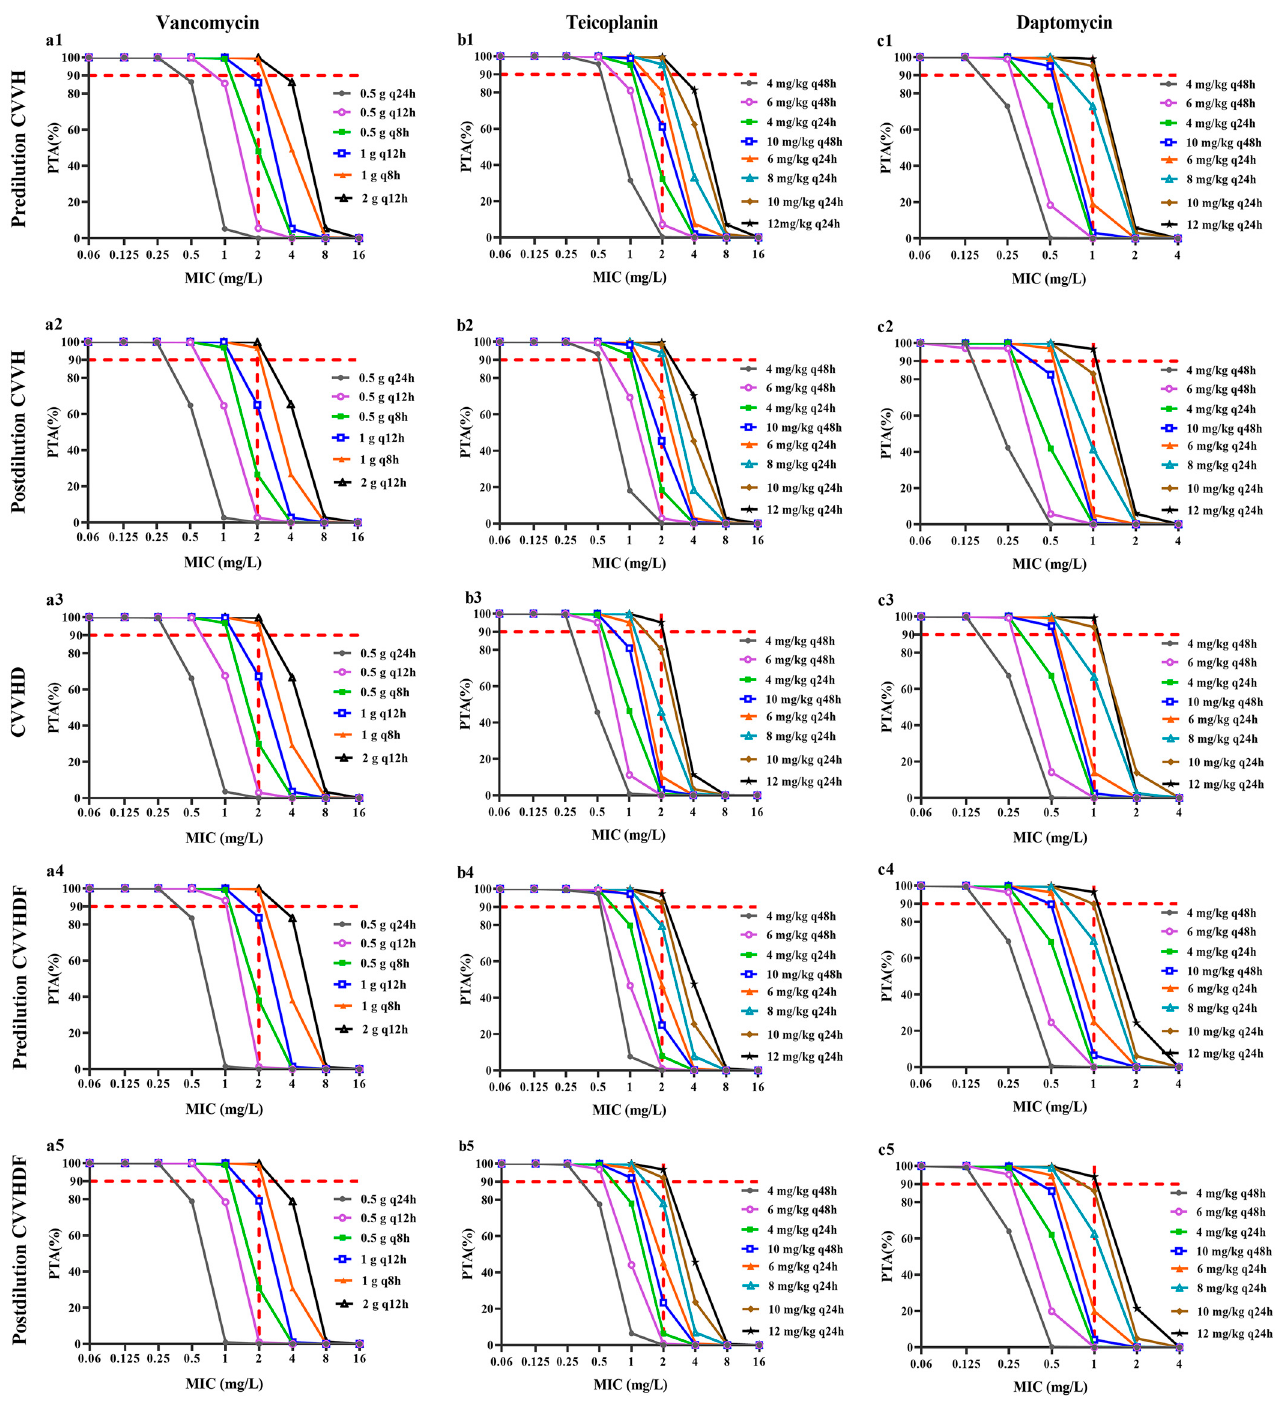
Figure 2. The probability of target attainment (PTA) values of three antimicrobial agents in different maintenance doses for patients undergoing different continuous renal replacement therapy modalities. The red dashed horizontal line indicates 90% PTA. The red dashed vertical line indicates the breakpoints of antimicrobial agents for MRSA. ( a )—Vancomycin; ( b )—Teicoplanin; ( c )—Daptomycin; ( a1 – c1 )—pre ‐ dilution CVVH; ( a2 – c2 )—pre ‐ dilution CVVH; ( a3 – c3 )—CVVHD; ( a4 – c4 )—pre ‐ dilution CVVHDF; ( a5 – c5 )—post ‐ dilution CVVHDF.